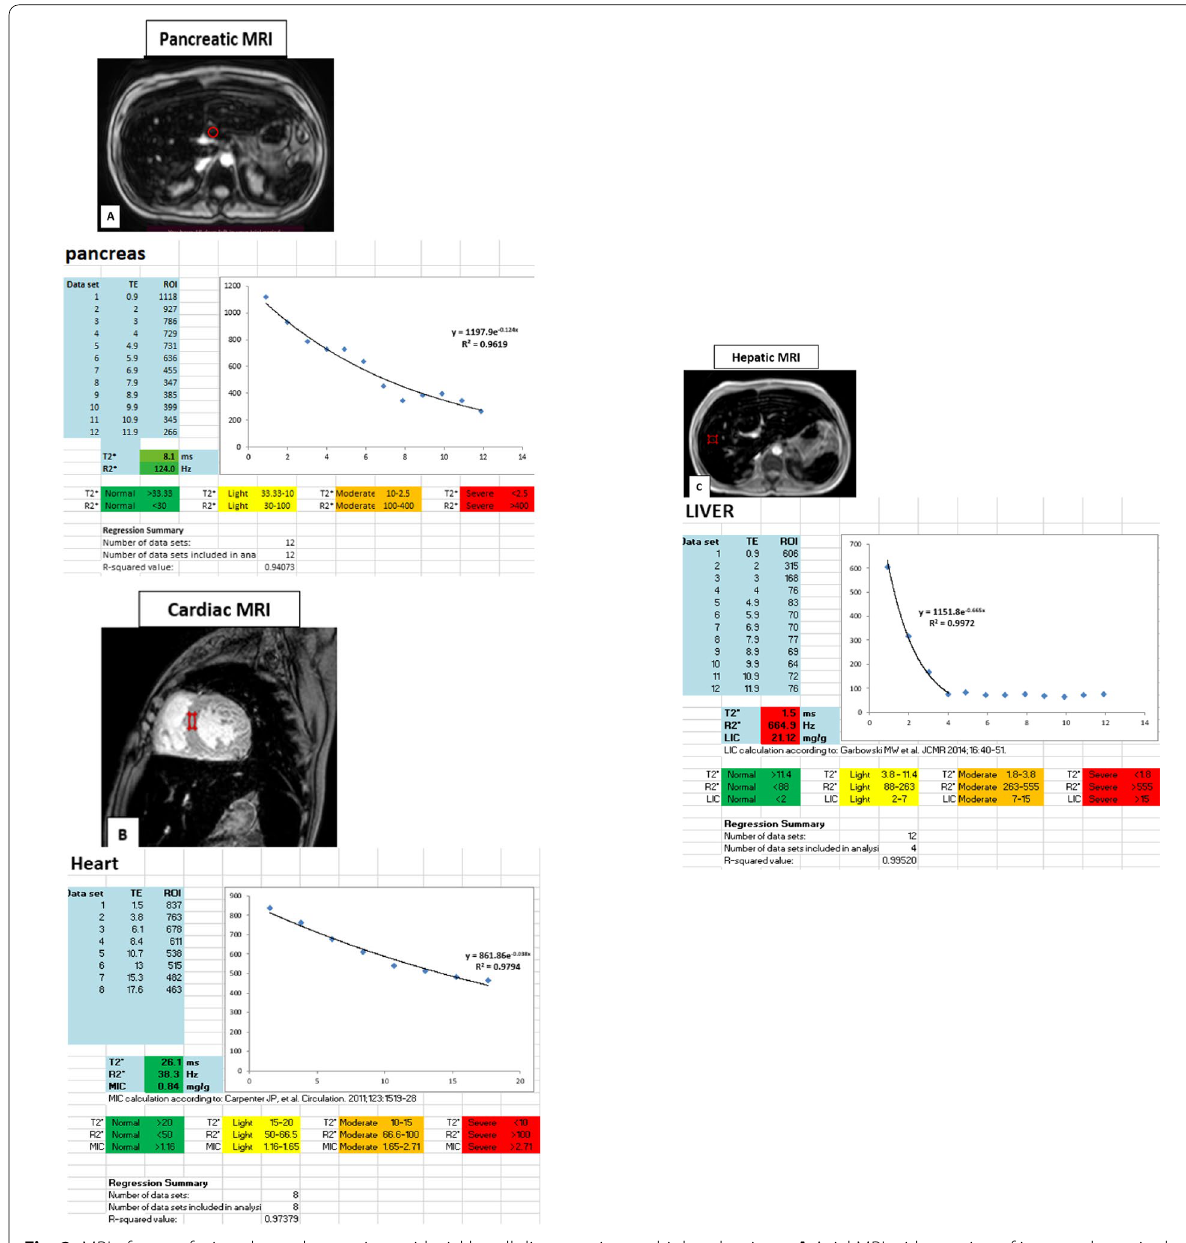
Fig. 2 MRI of a transfusion-dependent patient with sickle cell disease using multiple echo times. A Axial MRI with a region of interest drawn in the head of the pancreas. B Left ventricular short-axis black blood MRI images sequence with a region of interest drawn at mid interventricular septum. C Axial MRI liver with a region of interest drawn in the periphery of the right lobe of the